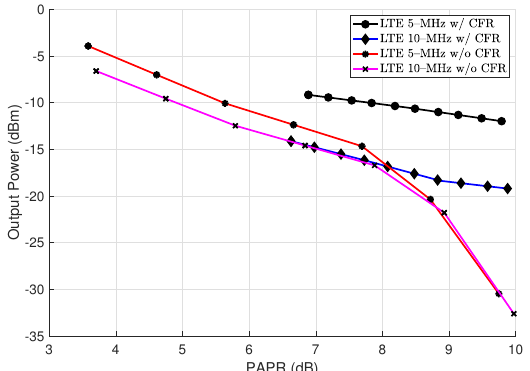
Figure 4. LTE 5–MHZ and 10–MHz signal PAPR vs. output power level with and without CFR